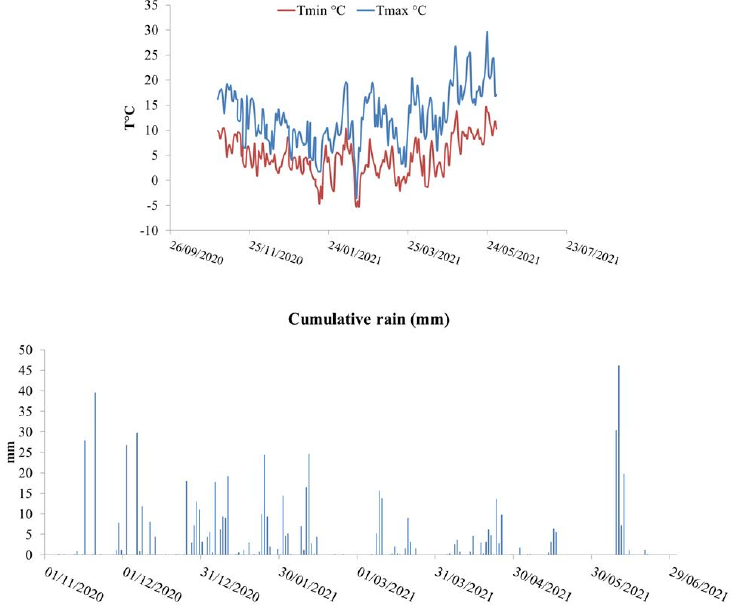
Figure 1. Meteorological data: daily minimum (Tmin °C) and maximum (Tmax °C) ( top ) and cumulative rain during the growth season 2020–2021 ( bottom ).